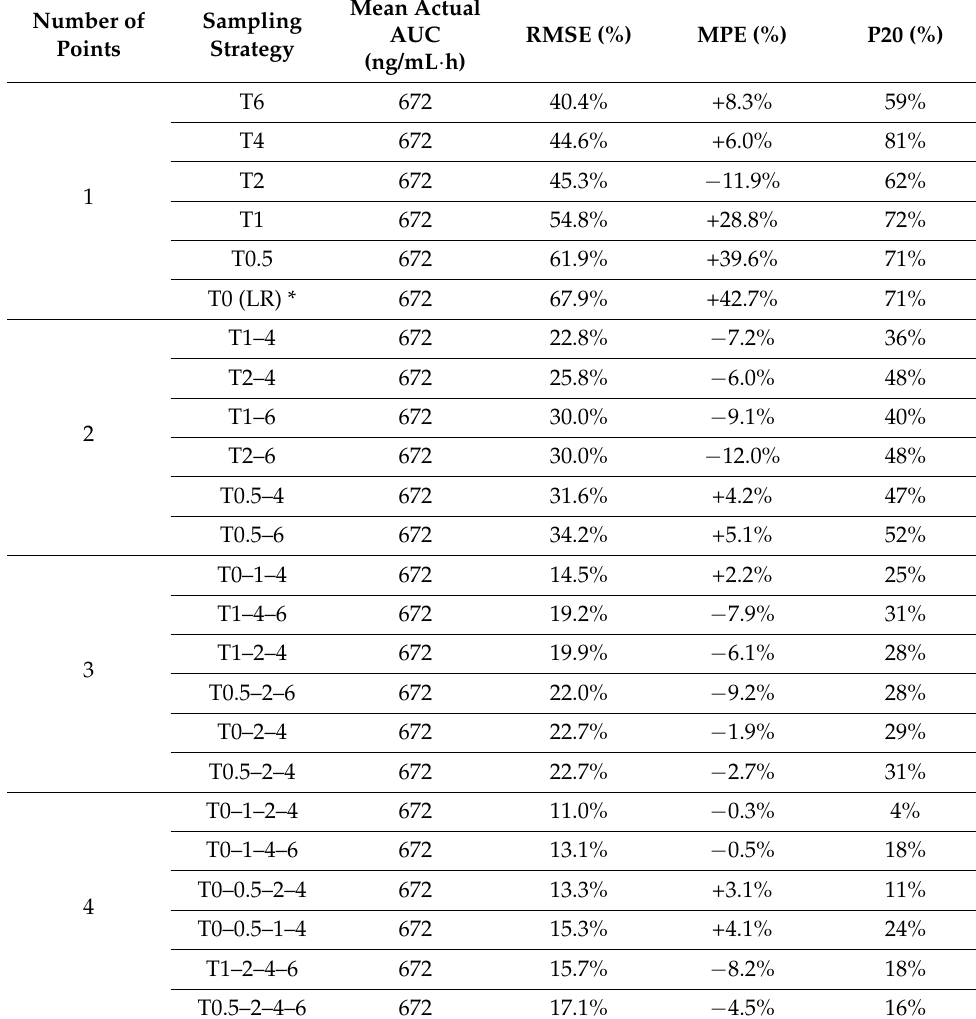
MPE: mean percentage error; P20: proportion of patients with a residual error superior to +/ − 20%; RMSE: root-mean-square error; * AUC derived from the linear regression (LR) equation of actual ibrutinib AUC